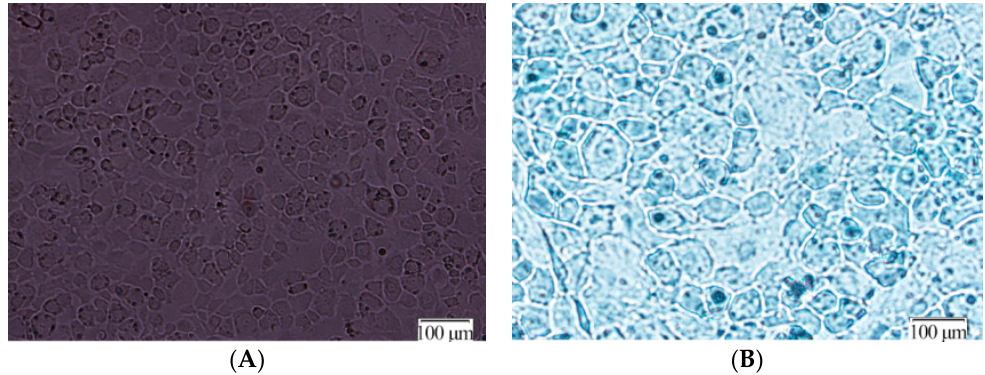
Figure 3. Phenotyping of articular chondrocytes. ( A ) The chondrocyte morphology with a rounded or polygonal shape; ( B ) the presence of sulfated proteoglycans.